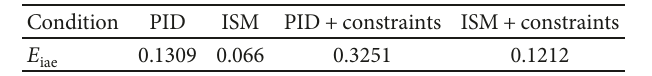
Figure 7: The output power of MT and EVs with power output Table 3: The sum of frequency deviation.